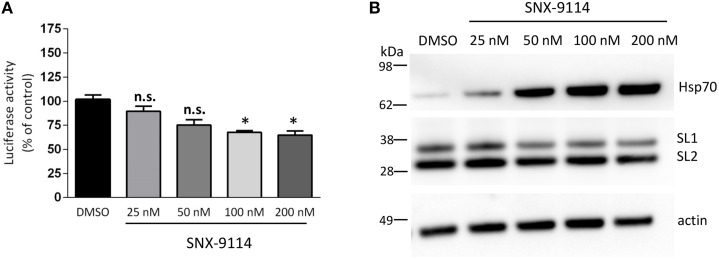
Effect of SNX-9114 on αsyn oligomerization in cell culture. (A) A range of concentrations of SNX-9114 was added to SL1SL2 cells stably overexpressing hαsyn for 24 h. The extent of intracellular αsyn oligomers was evaluated by luciferase assay and was normalized to DMSO control. Oligomerization was significantly decreased with a 100 and 200 nM doses (*p < 0.05). (B) Induction of Hsp70 after treatment with SNX-9114 on SL1SL2 cells was monitored by western blot as well as the expression of h-αsyn. Actin was used as a loading control. Data are given as mean ± S.E.M., from three independent experiments. Statistical analysis: One-way ANOVA followed by Tuckey's multiple comparison test. n.s., not significant.